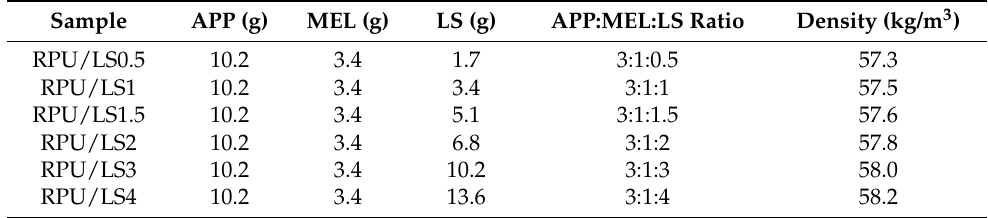
Table 2. The ratio of LS as a char forming agent in IFR formulations for RPU